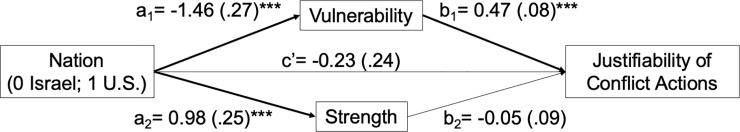
Unstandardized path coefficients (standard errors) of model assessing the mediating roles of perceptions of vulnerability and strength in the relation between nation in conflict and perceived justifiability of actions (Study 1).*** p < .001. a1b1 = Indirect effect of nation in conflict on action justifiability through perceived vulnerability; a2b2 = Indirect effect of nation in conflict on action justifiability through perceived strength; c' = Direct effect of nation in conflict on action justifiability.